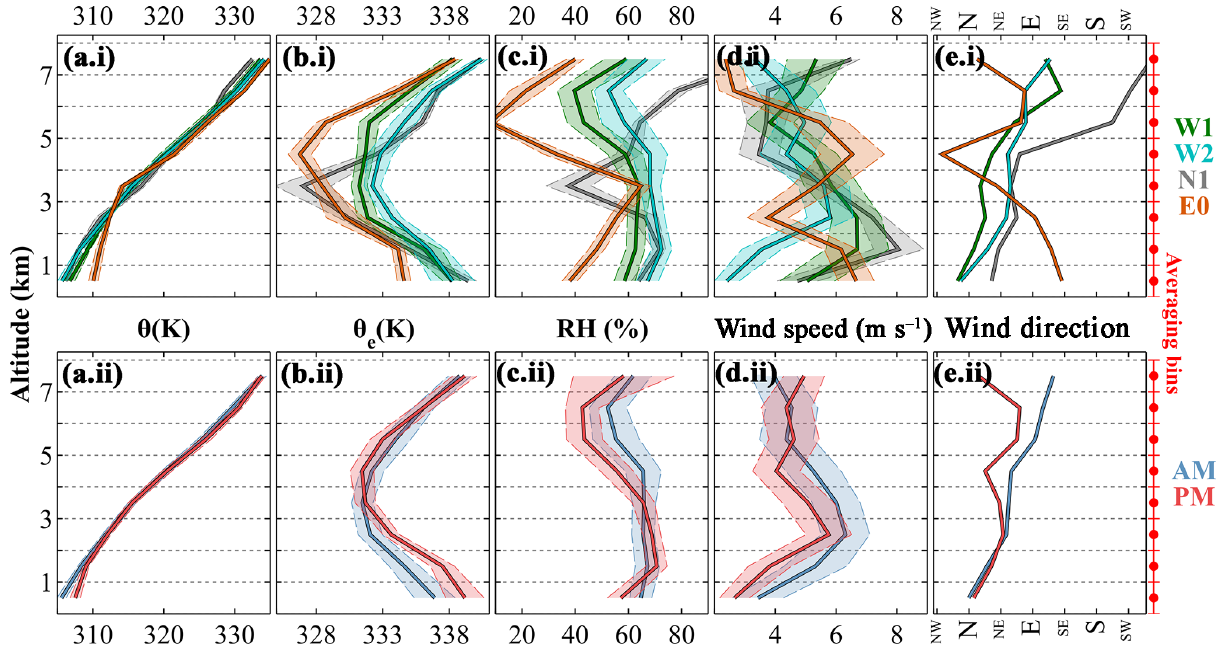
Figure 7. Median pollutant profiles averaged over the different regimes (a.i–e.i) and time of day ( a.ii–e.ii , includes data from all regimes). Lighter shading represents the median absolute deviation.